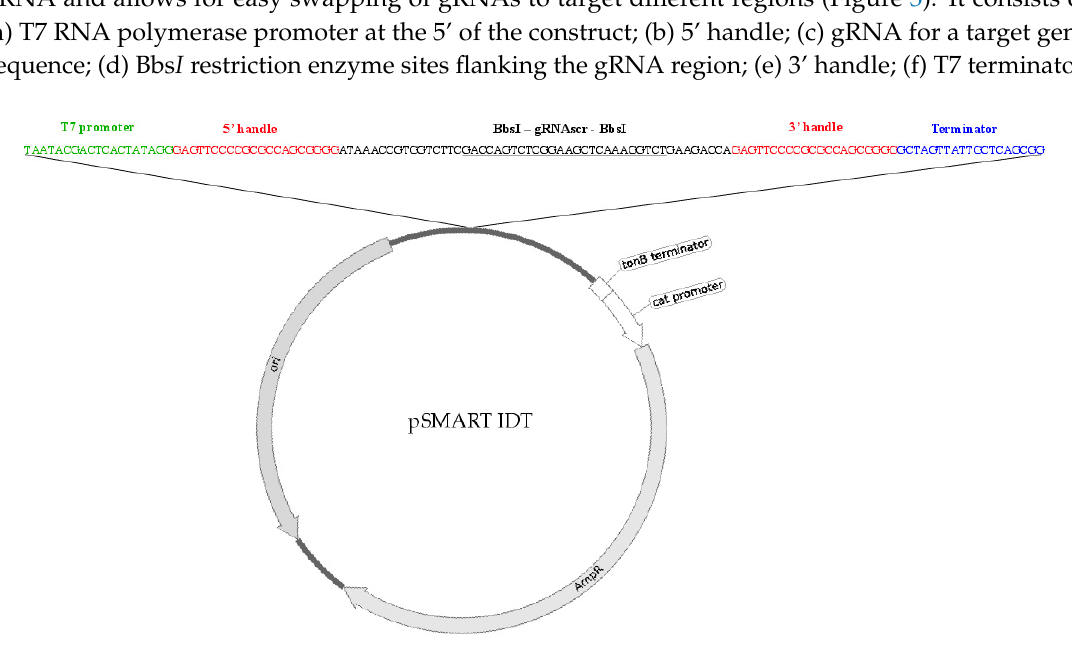
Figure 3. A schematic representation of the vector pAG_1. A 130 bp fragment consisting of a T7 promoter, two handle regions, non-targeting gRNA(scr) with two surrounding BbsI restriction sites and a T7 terminator.